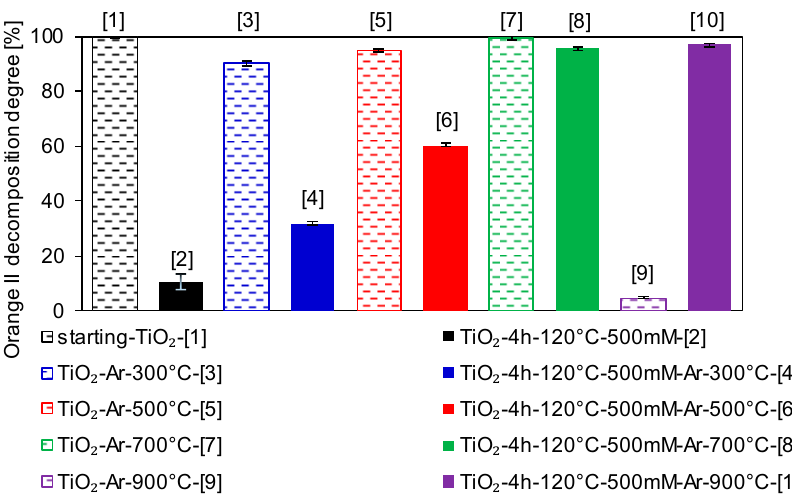
Figure 10. Orange II decomposition degree after 240 min of UV light irradiation for starting TiO 2 , calcined reference samples, and APTES-modified TiO 2 before and after calcination.